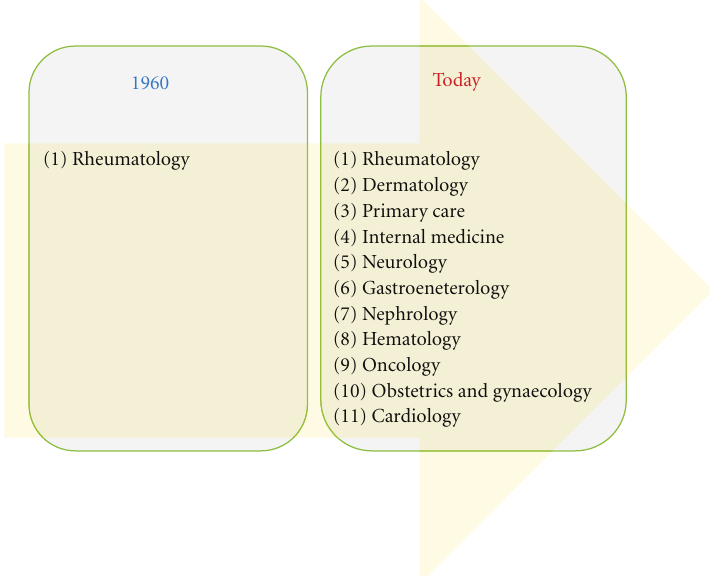
Figure 2: Change in ANA test referral patterns. Historically, when the ANA HEp-2 test became available in the 1960s exclusively rheumatologist ordered the ANA test. With the emerging recognition that many other diseases are associated with ANAs, a broad range of clinical disciplines order the ANA test.